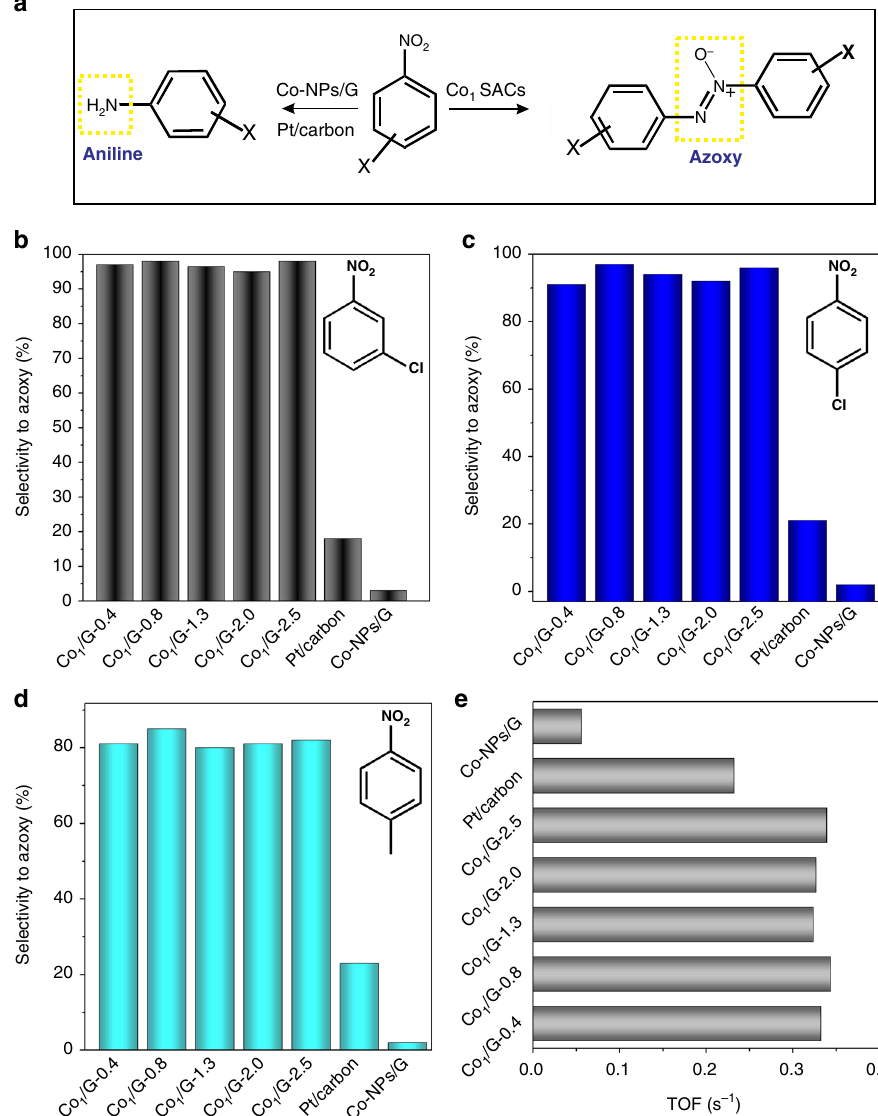
Fig. 4 Catalytic selectivity to azoxy products of various Co 1 /G SACs catalysts. a Schematic illustration of the hydrogenation of nitroarenes using different catalysts. Histograms of the selectivity to azoxy products for the hydrogenation of 1-chloride-3-nitrobenzene ( b ), 1-chloride-4-nitrobenzene ( c ), and 1- methyl-4-nitrobenzene ( d ) at ~100% conversion of nitroarenes by using different Co 1 /G SACs including Co 1 /G-0.4, Co 1 /G-0.8, Co 1 /G-1.3, Co 1 /G-2.0, Co 1 /G-2.5, Co-NPs/G, and Pt/carbon. e Turnover frequency (TOF) of the different catalysts tested in the selective hydrogenation of